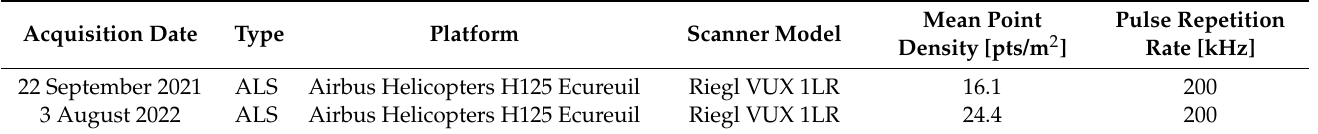
Table 2. Setup parameters for the pre-event (2021) and post-event (2022) LiDAR data